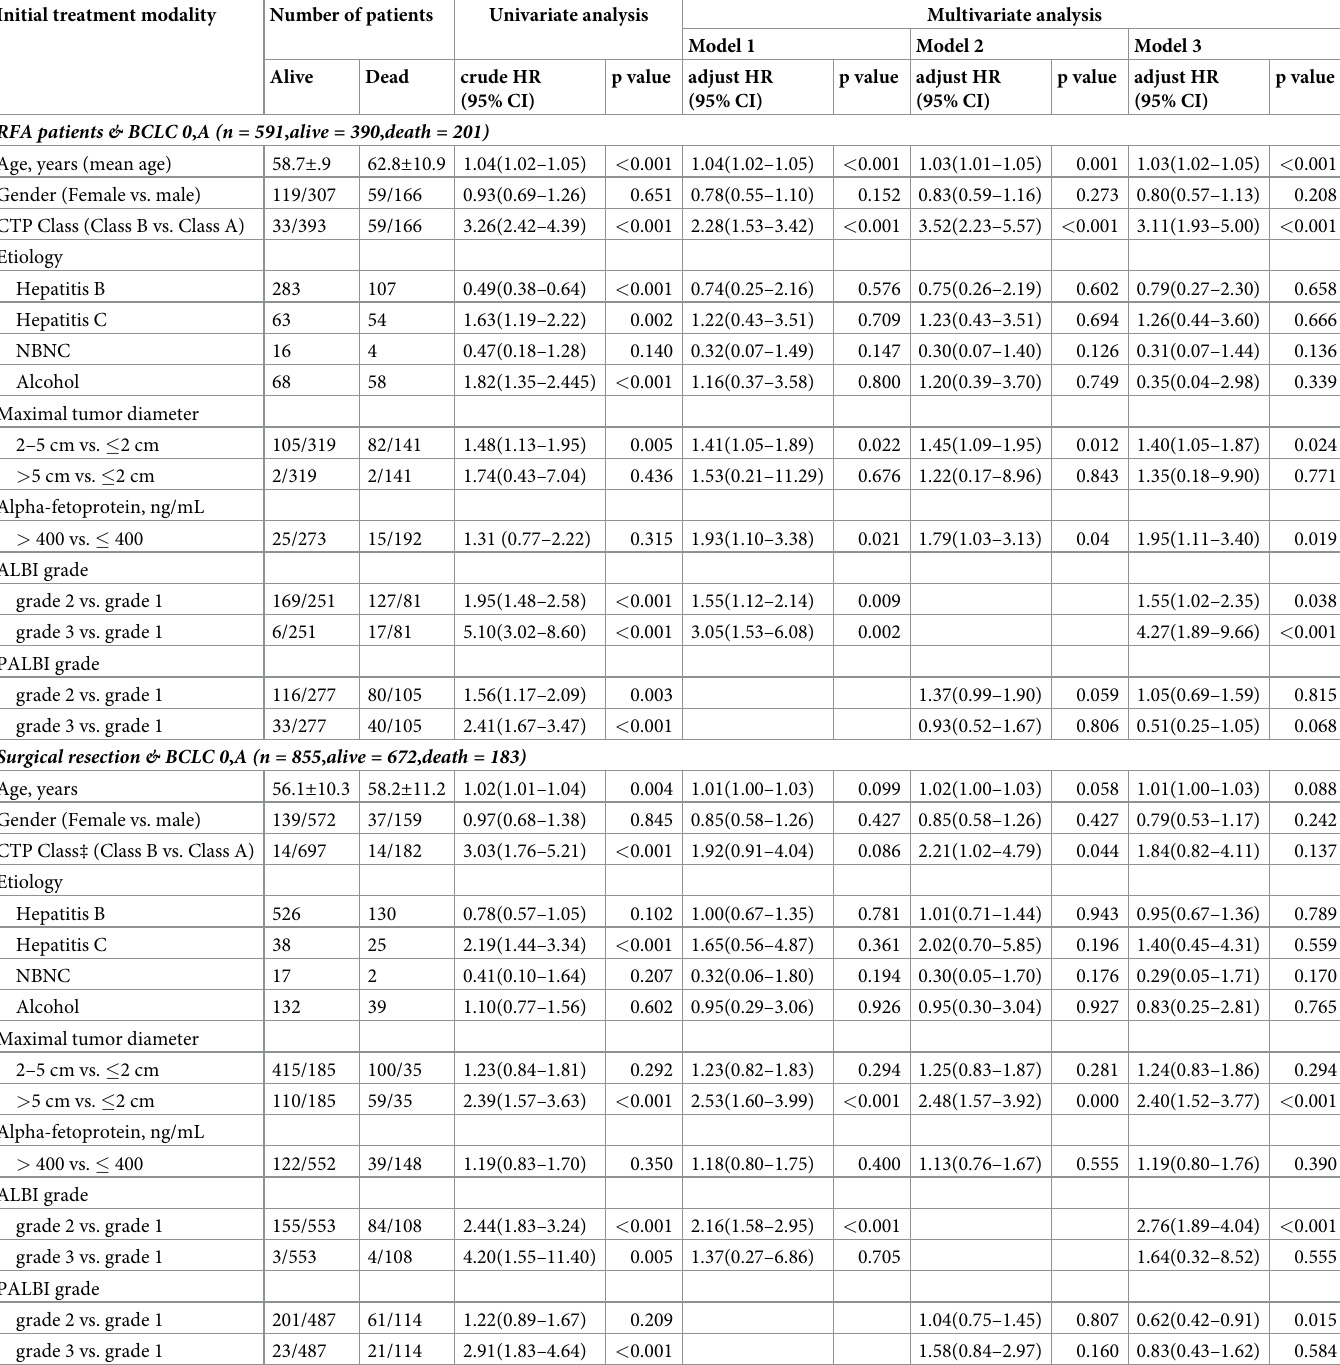
Table 5. Multivariate cox regression analysis on survival according to curative treatment modalities with BCLC